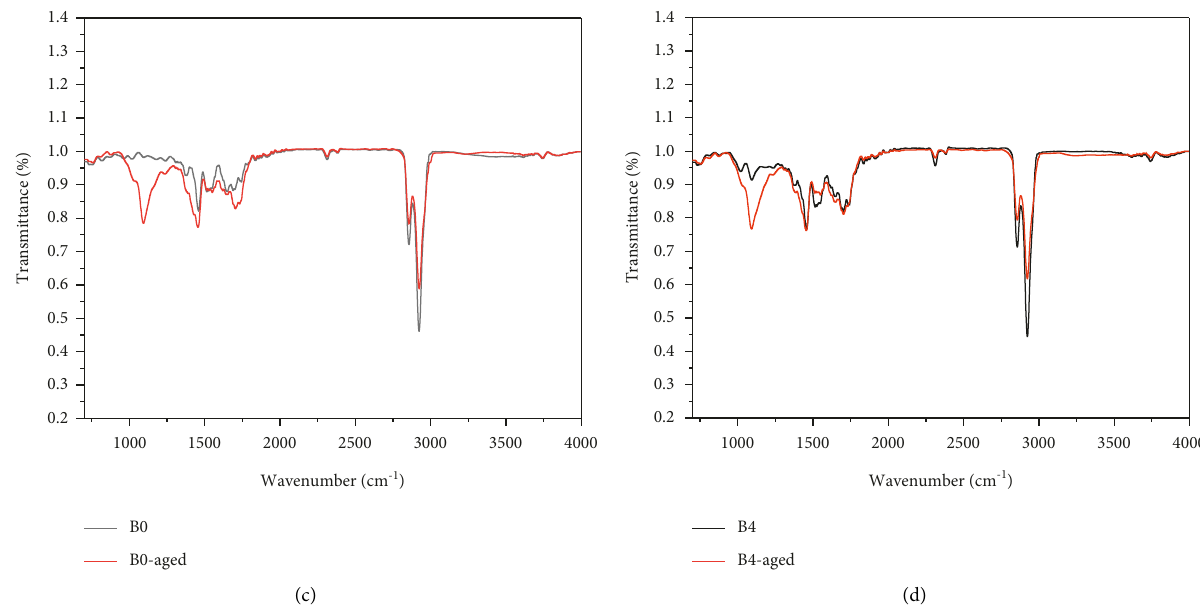
Figure 12: The results of the FT-IR spectra of the four bio-asphalts before and after aging. (a) A0, (b) A4, (c) B0, and (d) B4.